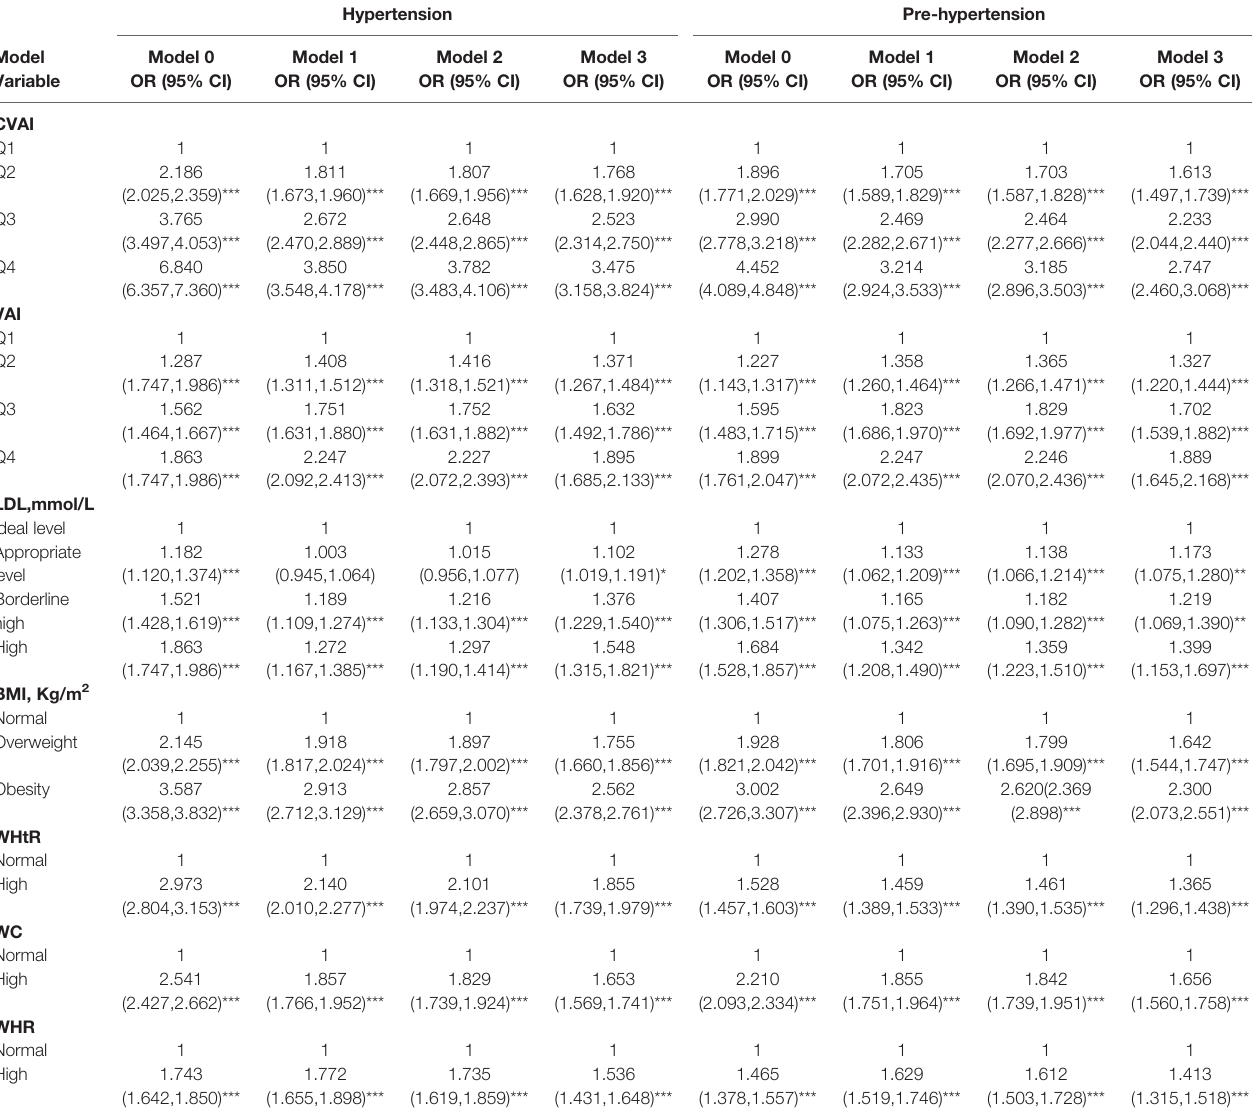
TABLE 2 | Association of CVAI, VAI, BMI, WC, WHtR, WHR and LDL-C with hypertension and